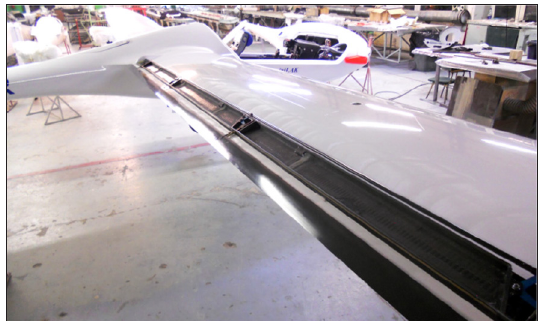
Fig. 10. VGMF control mechanism for the flaps (Photo: P. Lauk)